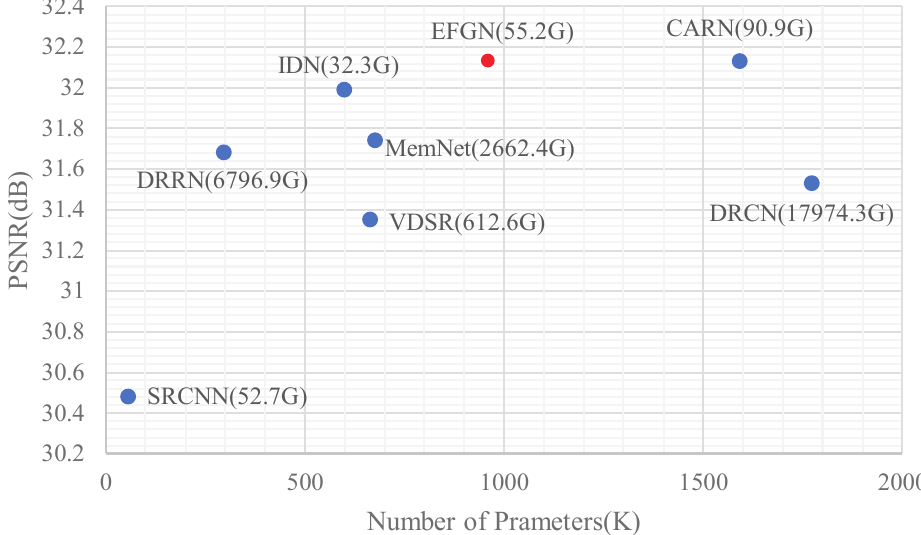
Figure 4. Trade-off between the model complexity and reconstruction performance with scale factor × 4 on Set5. The number after each method indicates the computational costs.